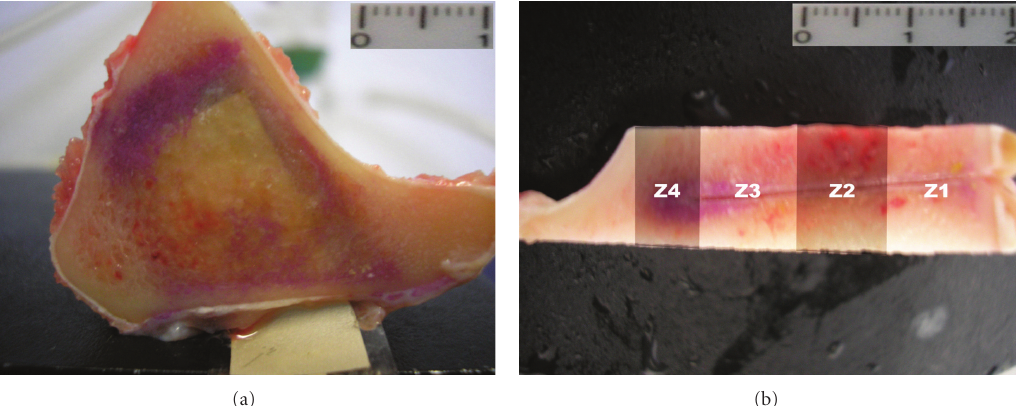
Figure 1: Location of the actuators within the bone. The figure shows example of bone section prior to inclusion: (a) section of tibia—scale bar 1cm; (b) shows how the areas for histomorphometry were distributed; Z1 corresponds to the film clamped region—scale bar 2